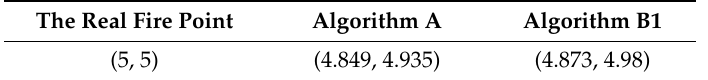
Table 3. The circle centers of real fire point and its estimates by Algorithms A and B1.